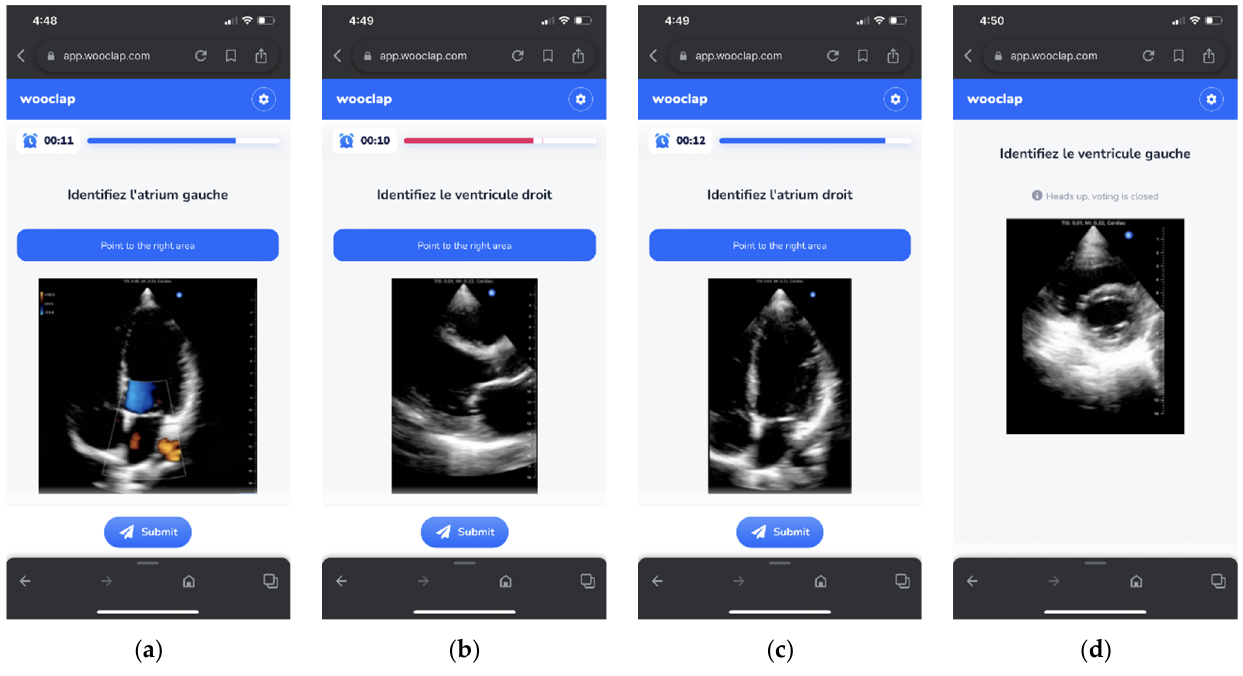
Figure 1. Wooclap US images test by example: ( a ) apical 4-chamber view with color Doppler—identify the left atrium; ( b ) parasternal long-axis view—identify the right ventricle; ( c ) apical 4-chamber view—identify the right atrium; ( d ) short-axis view at the level of papillary muscles—identify the left ventricle.